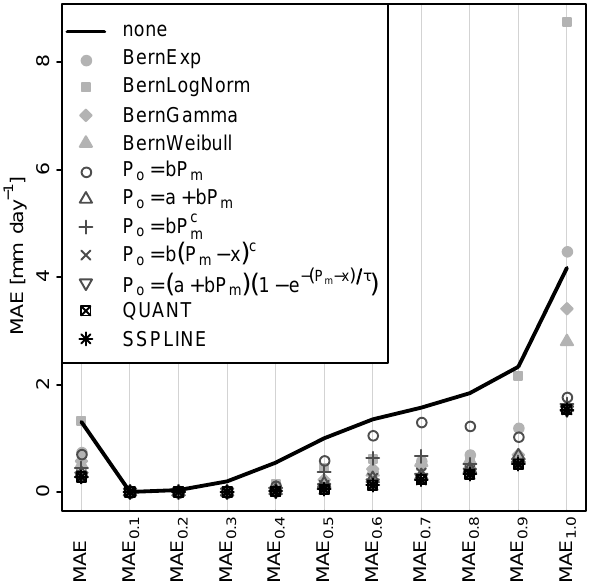
Fig. 3. Total mean absolute error (MAE) and the mean abso- lute error for specific probability intervals (MAE 0 . 1 , MAE 0 . 2 , ... , MAE 1 . 0 ), averaged over all